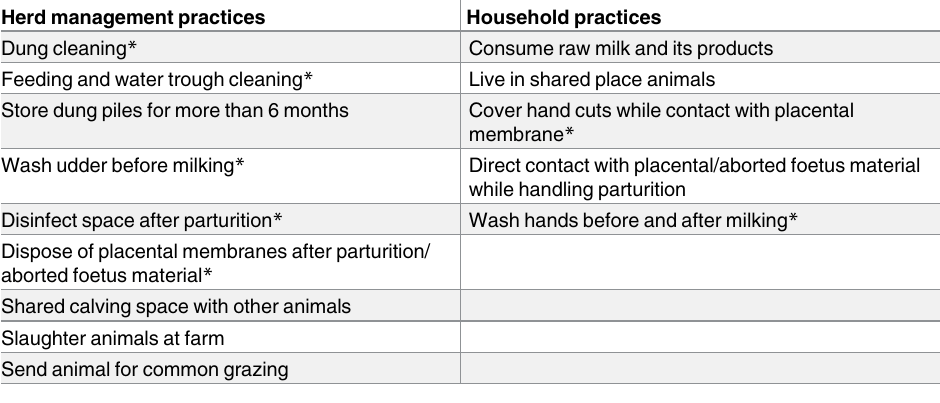
Table 2. Farm and household practiceswhich pose risk of contracting brucellosis in animals and humans, included in a questionnaire among smallholder dairy farmersin Pakistan. Herd management